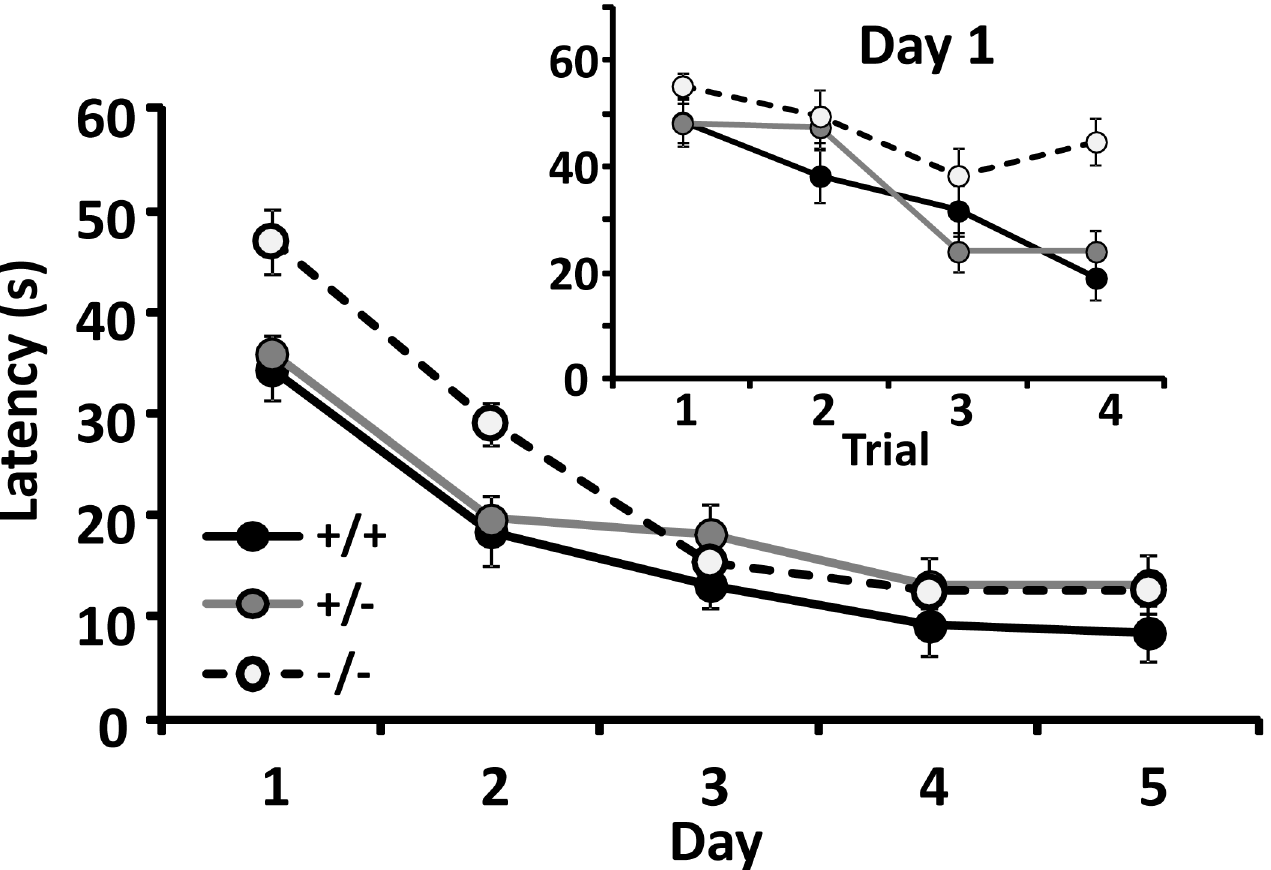
Fig 6. Morris water maze performance: time to reach platform in mice with different CSMD1 genotypes. Main Fig : Averaged daily latencies ± SEM to reach the Morris water maze platform for wildtype, heterozygous and homozygous CSMD1 knockout mice (repeated measures ANOVA genotype * day interaction p = 0.004 for learning. There were no significant differences in swimming speed ( see text ). Inset : More detailed data showing latencies to reach the (visible) platform during the first four trials ( day 1 ). The trend for poorer performance in the homozygous knockouts reached the margin of statistical significance (p =